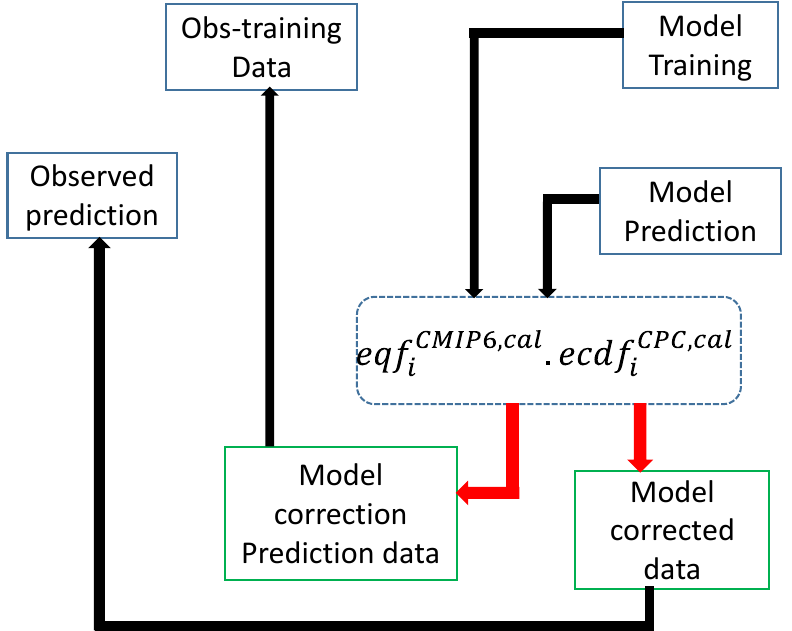
Figure 2. Flowchart of model bias correction procedure based on sample split testing technique.